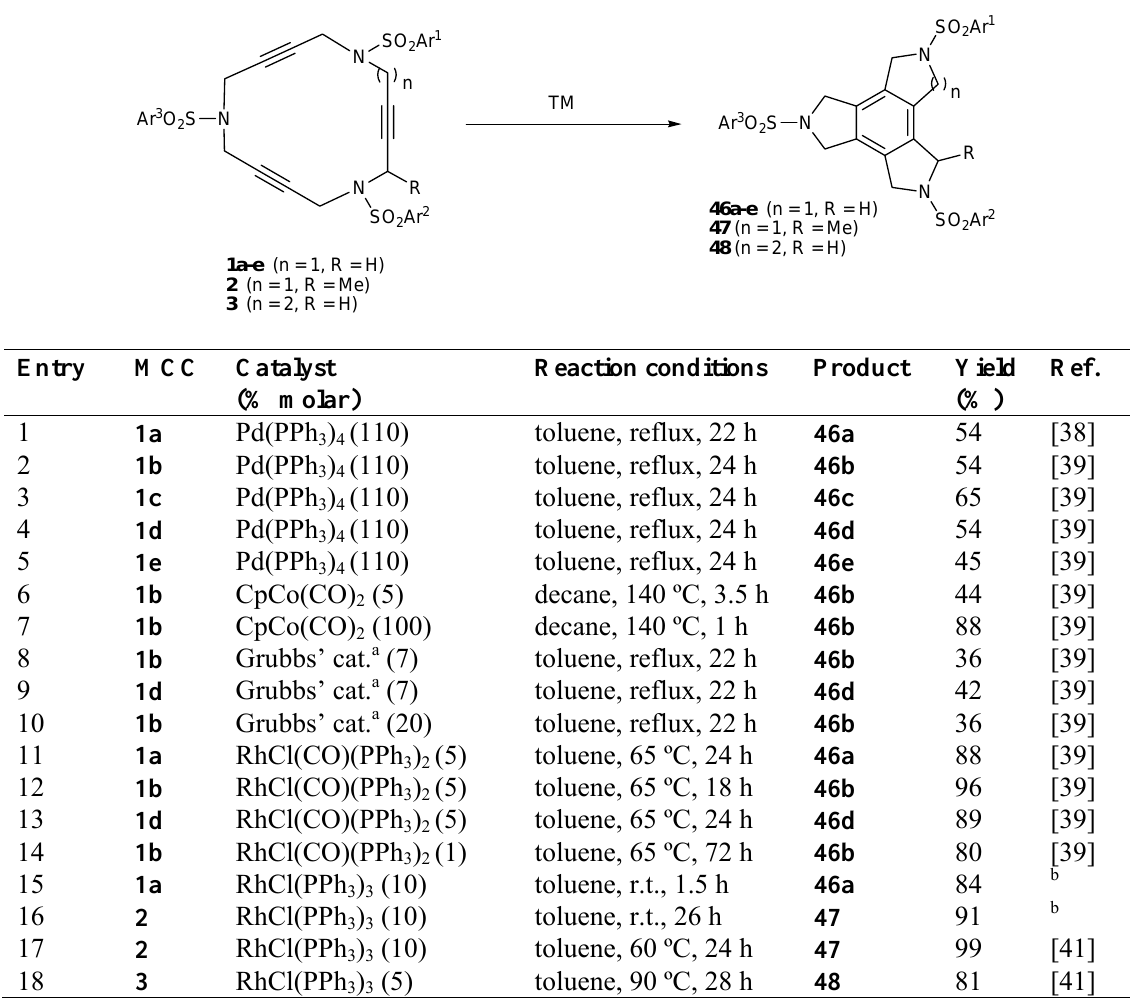
Table 1. Cycloisomerization reactions of macrocycles 1, 2 , and 3